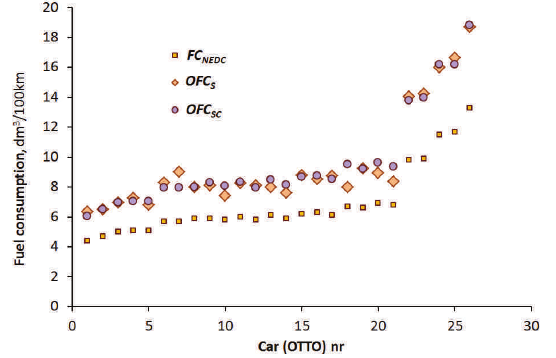
Fig. 5. Fuel consumption FC NEDC and in the road tests OFC S of vehicles with spark ignition engines The results obtained in the NEDC test are still different from the operational ones, but if you use the (10) type formu- la, then the UDC and EUDC (as the newer NEDC test) and the results from the controlled operation almost overlap.